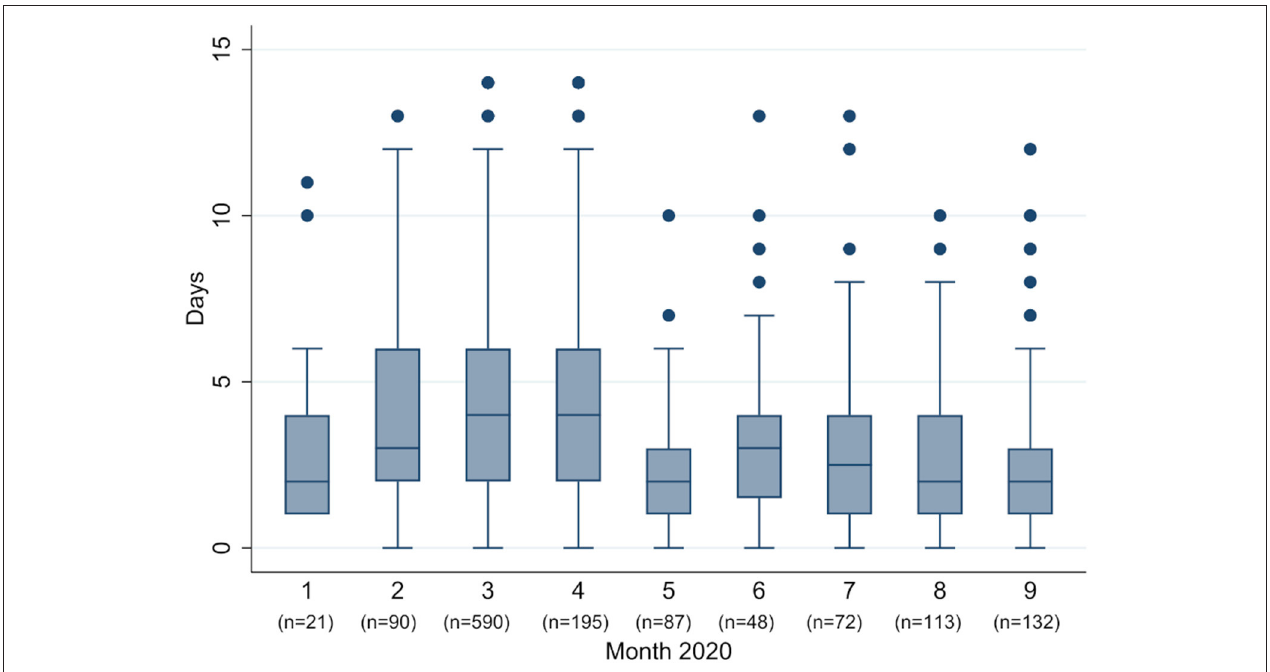
FIGURE 3 | Box plot of days since onset of symptoms, per month.